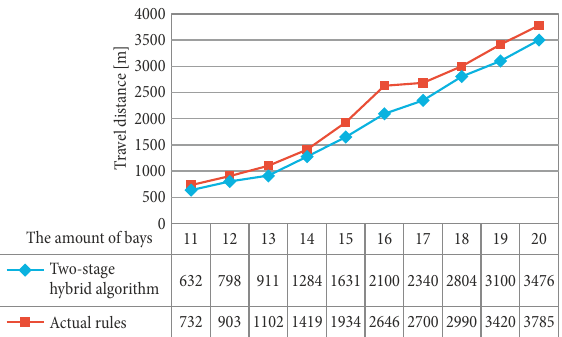
Fig. 7. Comparison of make-span between two-stage hybrid algorithm and actual rules for small-sized cases